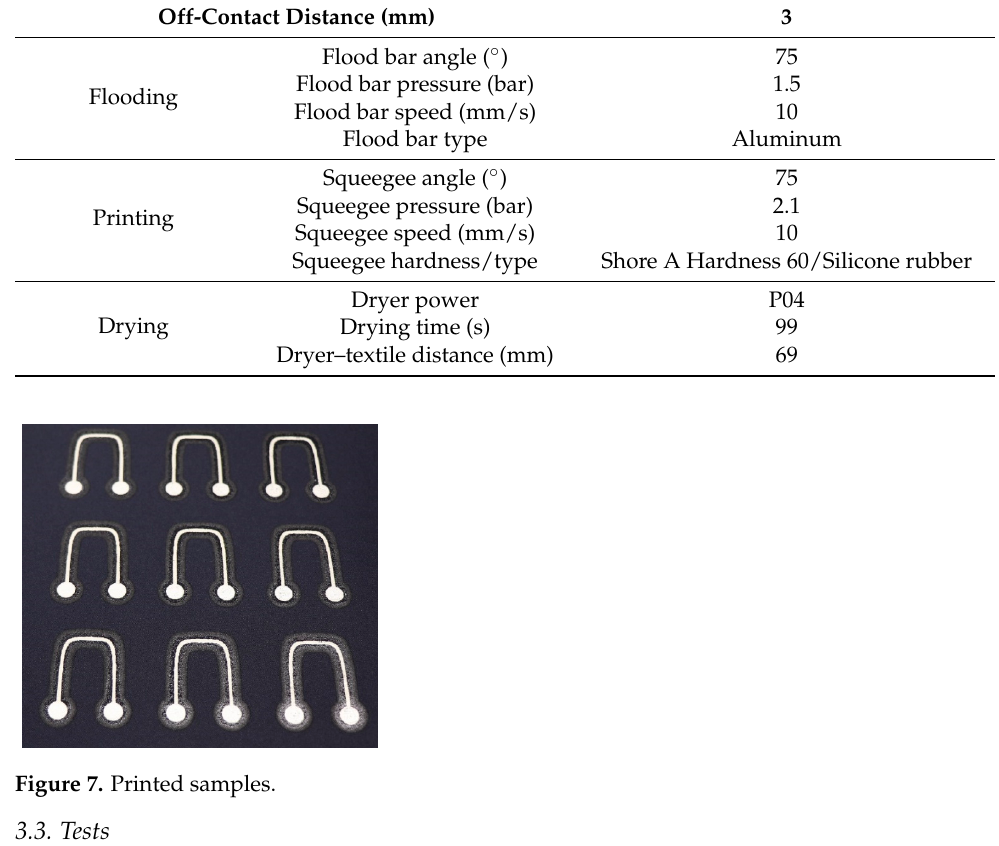
Figure 9. SEM image (cross section) of a sample coated once. To improve the barrier properties of the coating, protective layers were printed twice (double layer) to increase their thickness (Figure 10) and thus minimize the presence of continuous pores in the coating. In this case, the formation of hydrogen bubbles on the surface of the printed sample could not be detected during the pinhole test (Figure 8b). These results suggest that the developed diffusion-inhibiting pastes can be applied to tex- tiles by screen-printing as flexible protection for conductive patterns, and thus suggest that the pastes can be implemented in the fabrication of smart textiles.